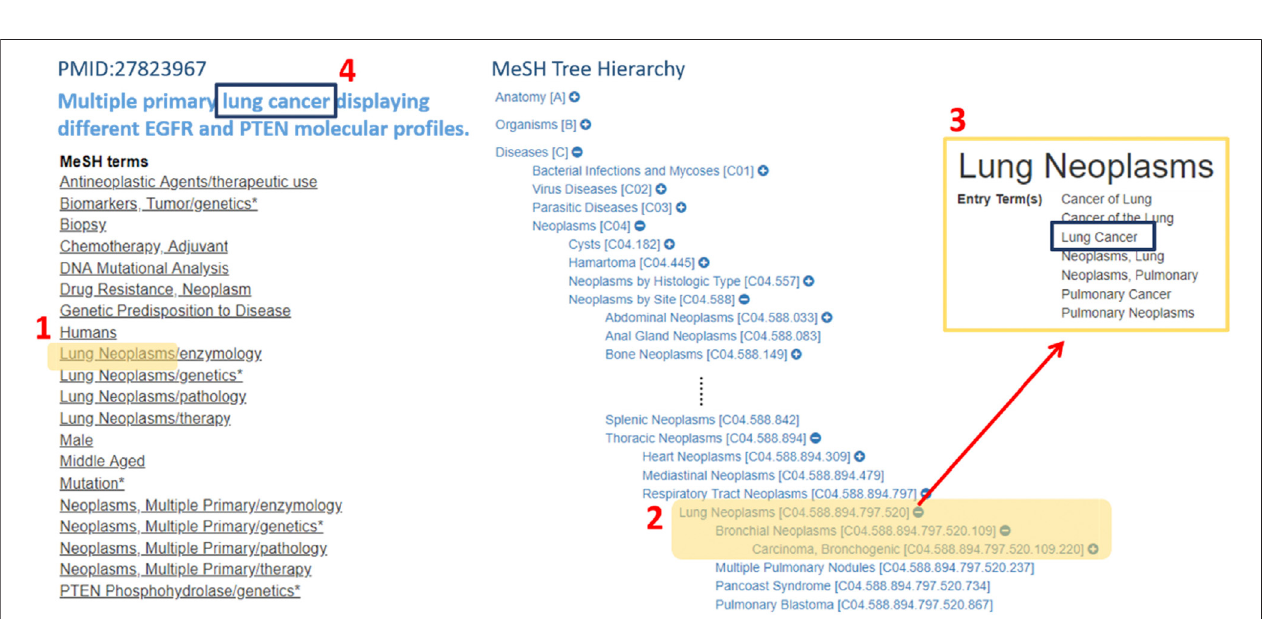
FIGURE2| Anexampledisplays how theterm “ lung cancer ” ,being tagged inMeSH hierarchicalstructure.Theway “ lung cancer ” being tagged isasfollows. First, we iterate through the MeSH terms of the index of PMID: 27823967 and found “ Lung Neoplasms ” was one of the MeSH terms, which its synonyms contain “ Lung Cancer. ” Second, if the term “ Lung Cancer ” also appeared in the article, the MeSH tagging algorithm would tag this word and take its MeSH ID for further analysis.